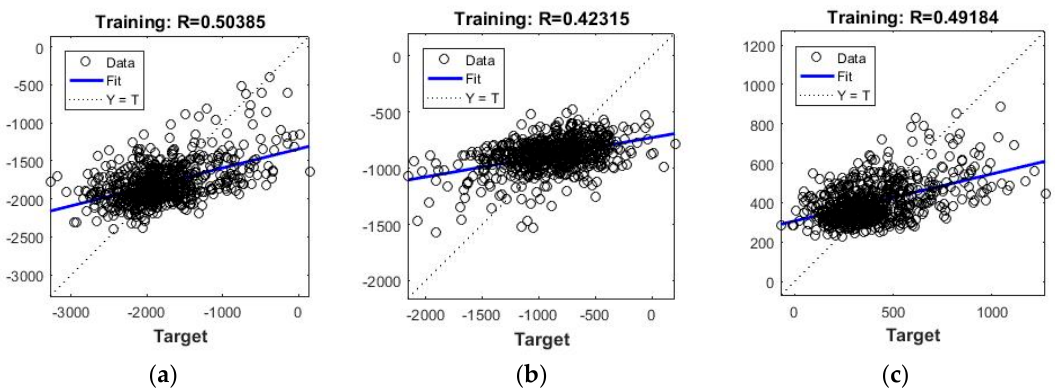
Figure 3. BNN two hidden layers fitting results based on the 85% of the samples: ( a ) RGB-NIR bands against GPR slice depth between 0.00–0.20 m; ( b ) RGB-NIR bands against GPR slice depth between 0.20–0.40 m; and ( c ) RGB-NIR bands against GPR slice depth between 0.40–0.60 m.